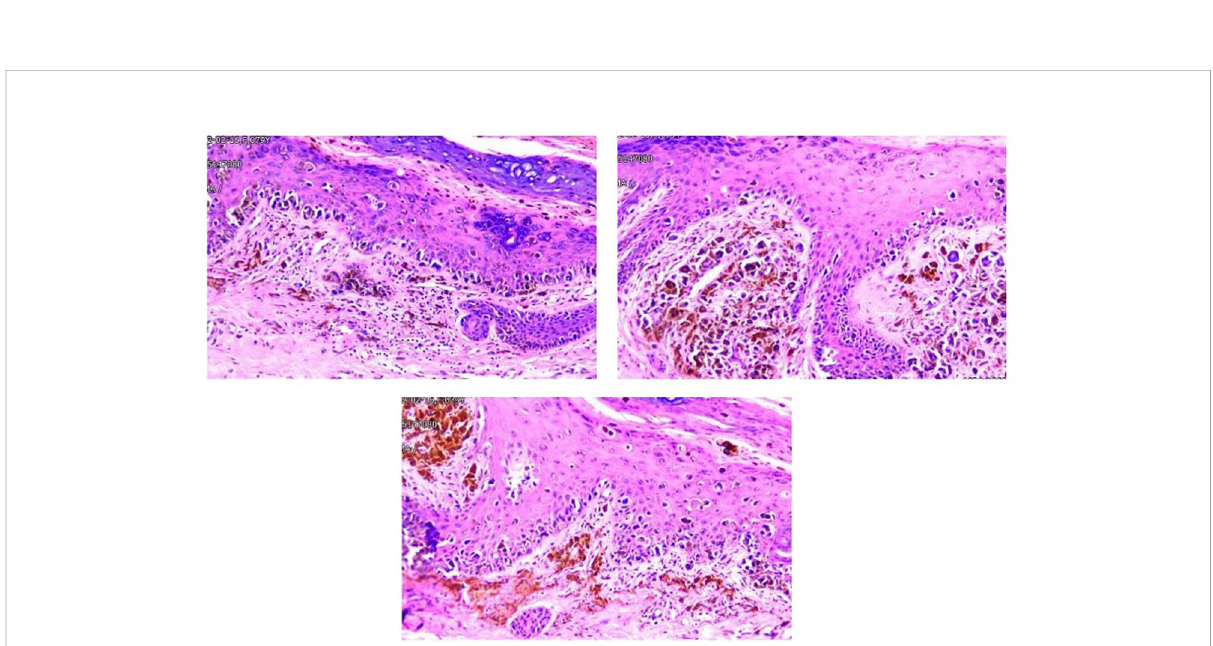
FIGURE 2 Tumor cells were found in the super fi cial dermis, the whole epidermis, and the inner corneal layer showed as nested sheets or scattered distribution. The ovoid and polygonal tumor cells had a distinct nuclear membrane, and an eosinophilic nucleolus, as well as abundant cytoplasm and melanin granules and an increased nucleoplasm ratio. Phagocytic melanocytes are found in the super fi cial